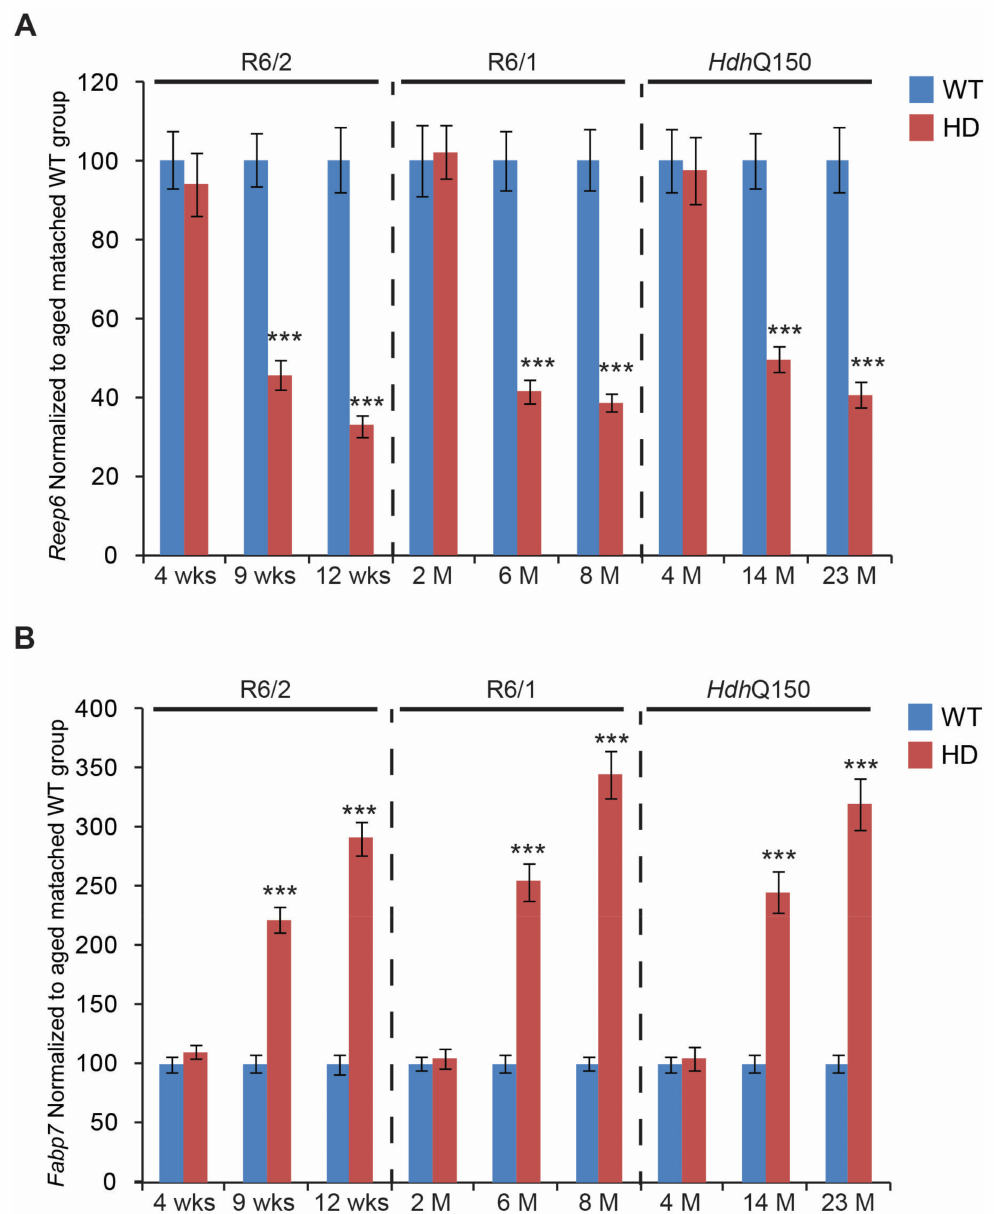
Figure 5. Transcriptional alterations of genes linked to retina degeneration. Transcripts of ( A ) Reep6 (Receptor expression enhancing protein 6) and ( B ) Fabp7 (fatty acid binding protein 7, brain), were assessed in the eyes of three HD mouse models at: pre-symptomatic stage (4 weeks R6/2 mice, 2 months R6/1 mice, and 4 months Hdh Q150 mice); symptomatic stage (9 weeks R6/2 mice, 6 months R6/1 mice, and 14 months Hdh Q150 mice), and end-stage (12 weeks R6/2 mice, 8 months R6/1 mice, and 23 months Hdh Q150 mice). All Taqman qPCR values were normalized to the geometric mean of three housekeeping genes, as indicated in the Materials and Methods section. Error bars are ± SEM (n = 6). SEM represents biological replicates. Student’s t -test: *** p <